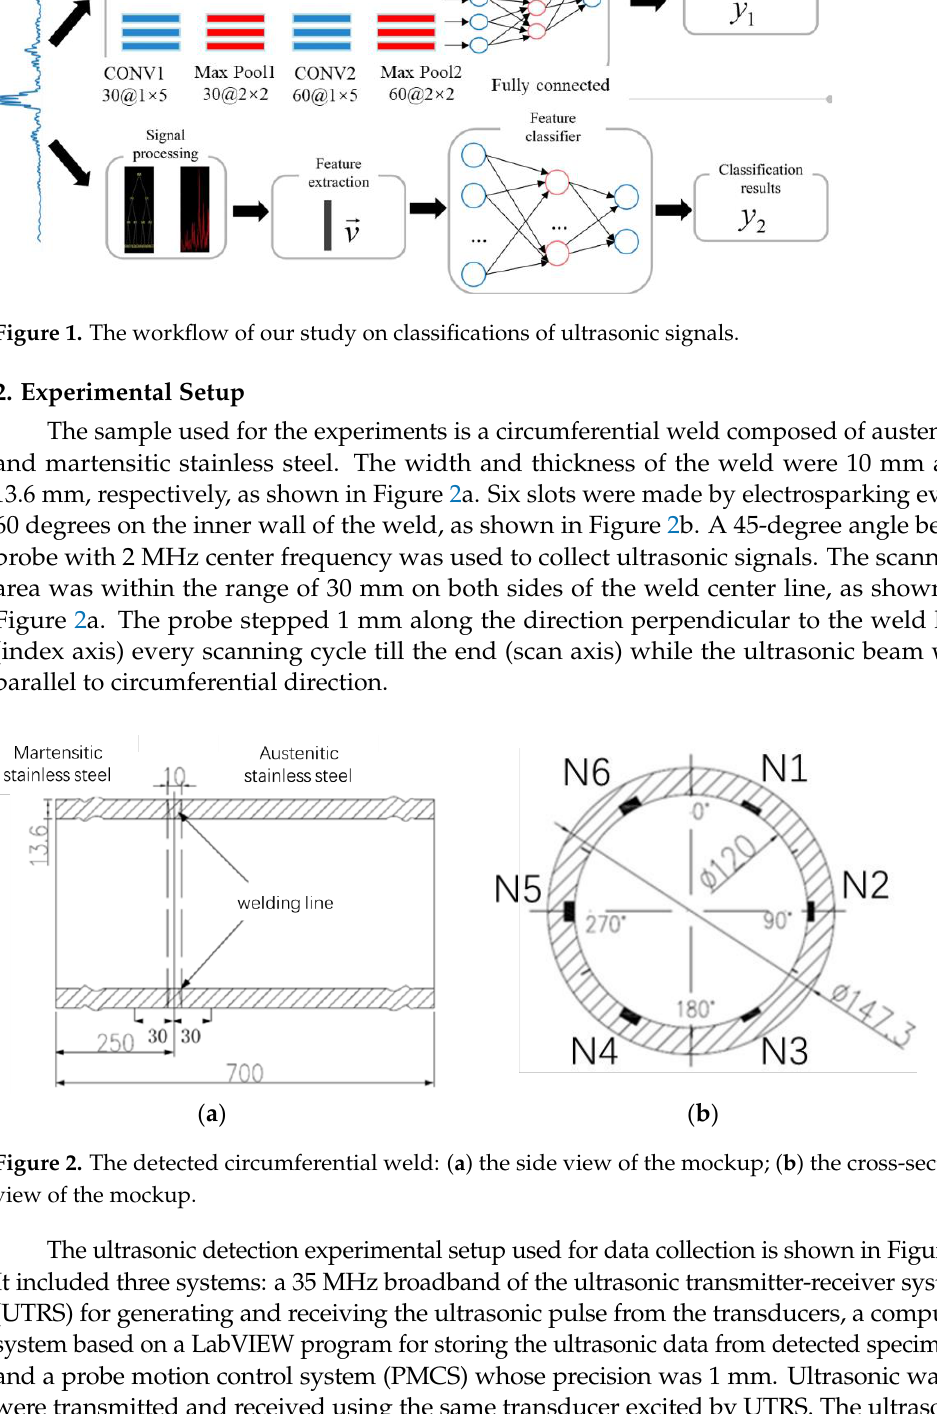
Figure 3. The ultrasonic detection experimental setup for data acquisition. 3. Method The convolutional neural network is a type of deep neural network that has convo- lutional layers as well as fully connected layers. Convolution is a mathematical function that is widely used in the signal processing domain. In the convolutional neural network, convolutional layers actually utilize a cross-correlation technique that is technically very similar to convolution [15]. There are two important layers in CNNs, i.e., feature extraction layers and classifica- tion layers. Convolutional layers and pooling layers are feature-extracting layers, while classification layers are fully connected layers. Convolutional layers are not connected to every node in the input layer but to specific local regions based upon the defined fil- ters/convolutional kernels. This architecture allows the network to concentrate on low- level features; these are then assembled into high-level features. CNN also has ability to learn a pattern at one location and then determine it in some other location. It is possible due to sharing the same parameter in filters. Pooling layer in the neural network is used to subsample the input that helps to reduce the computational load and also helps to avoid overfitting [15].